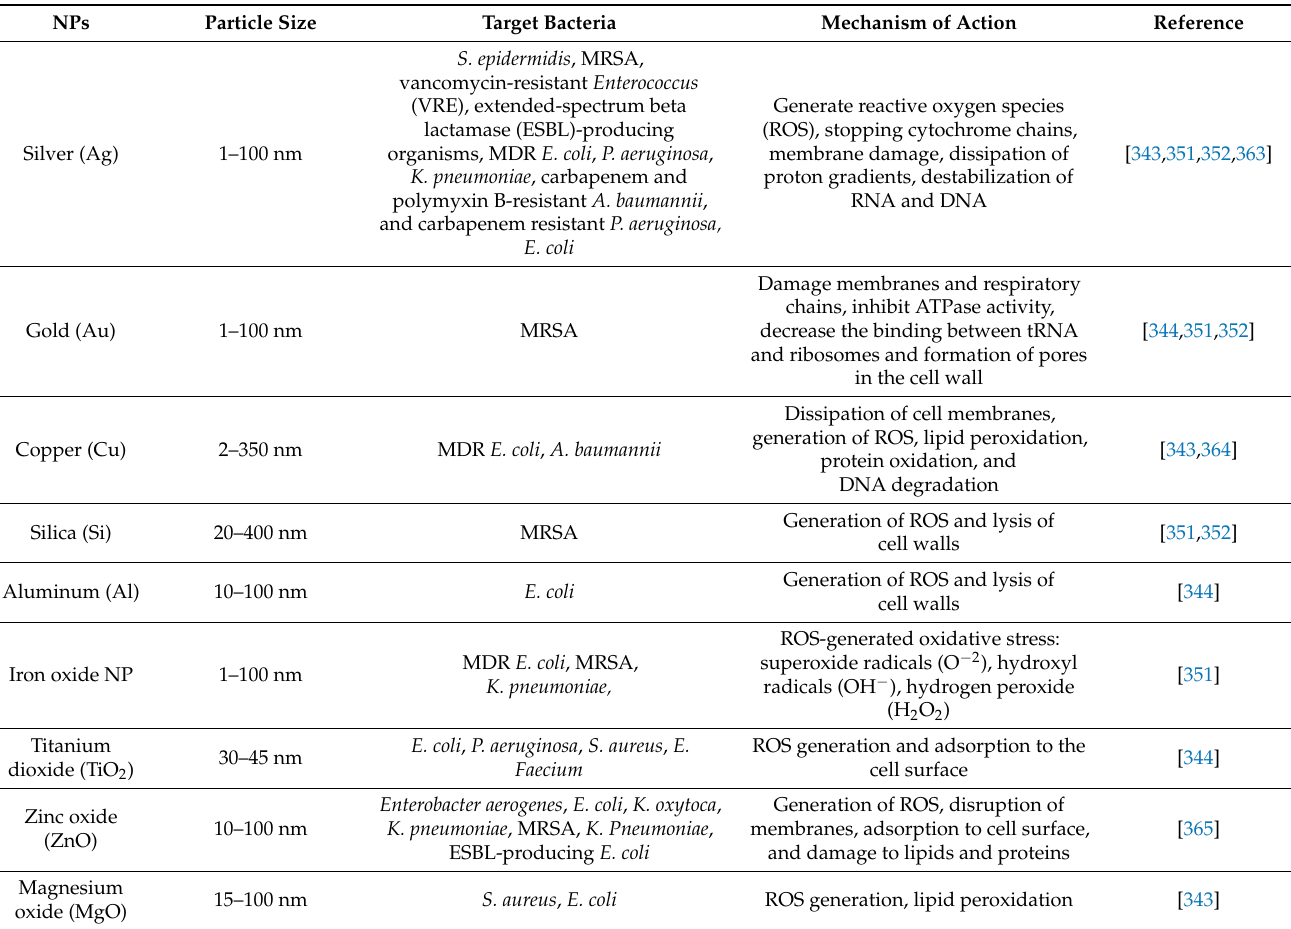
Table 5. Effects of nanoparticles on different pathogenic bacteria and the mechanism of their antimi- crobial